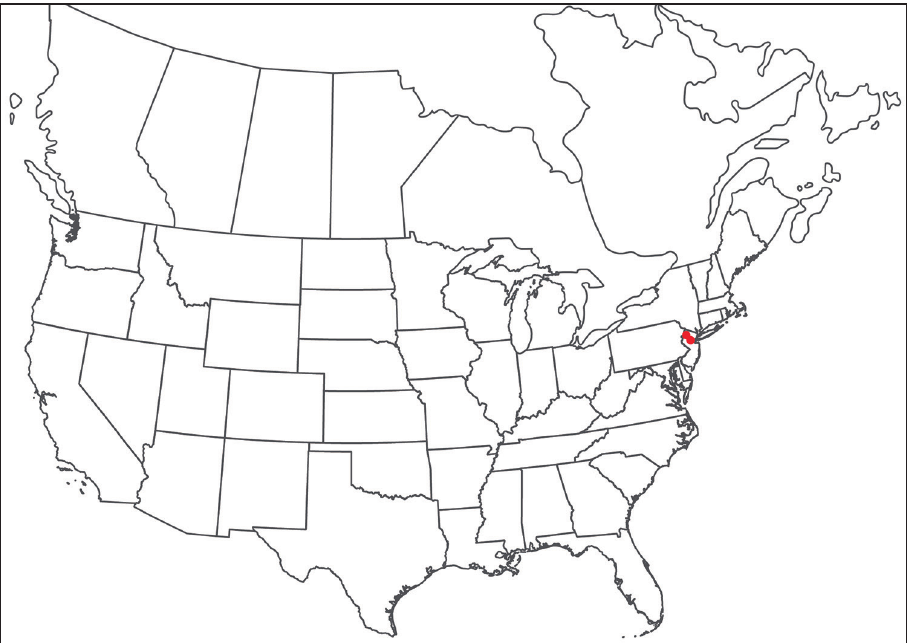
Figure 114. Torrenticola kittatinniana